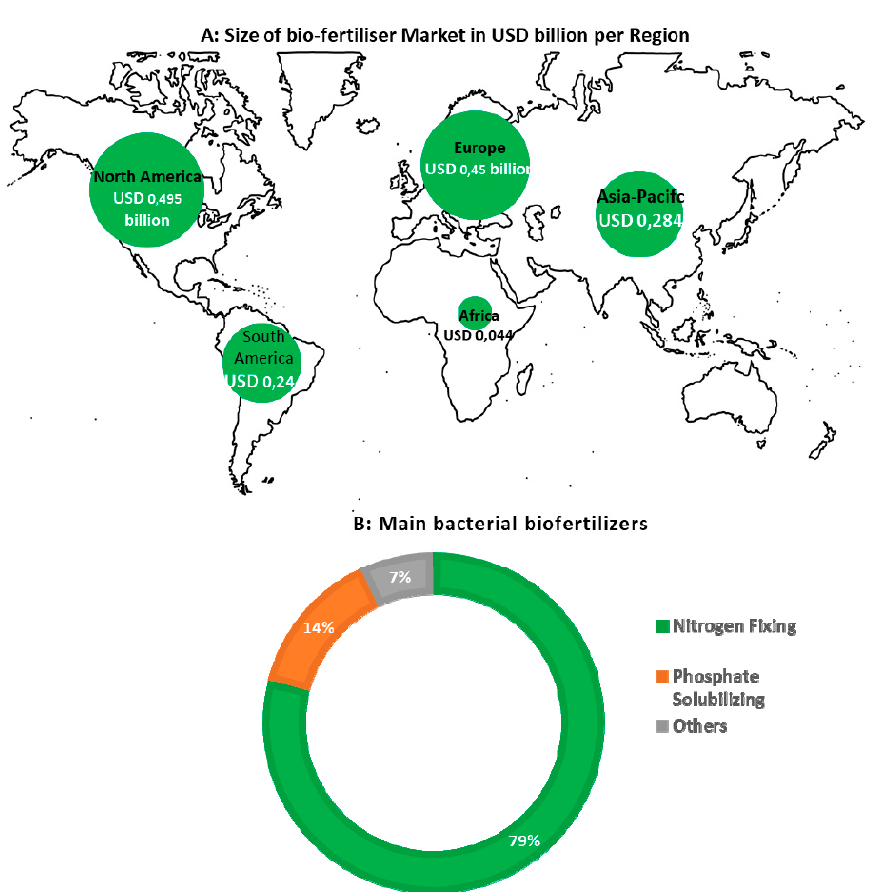
Figure 2. Global biofertilizers market and distribution. Data synthesized from Global Biofertilizers Market [84] and market data forecast [85]. ( A ): the diameter of each circle is proportional to the size of the market in USD billion. ( B ): percentage of main biofertilizers available in the market.